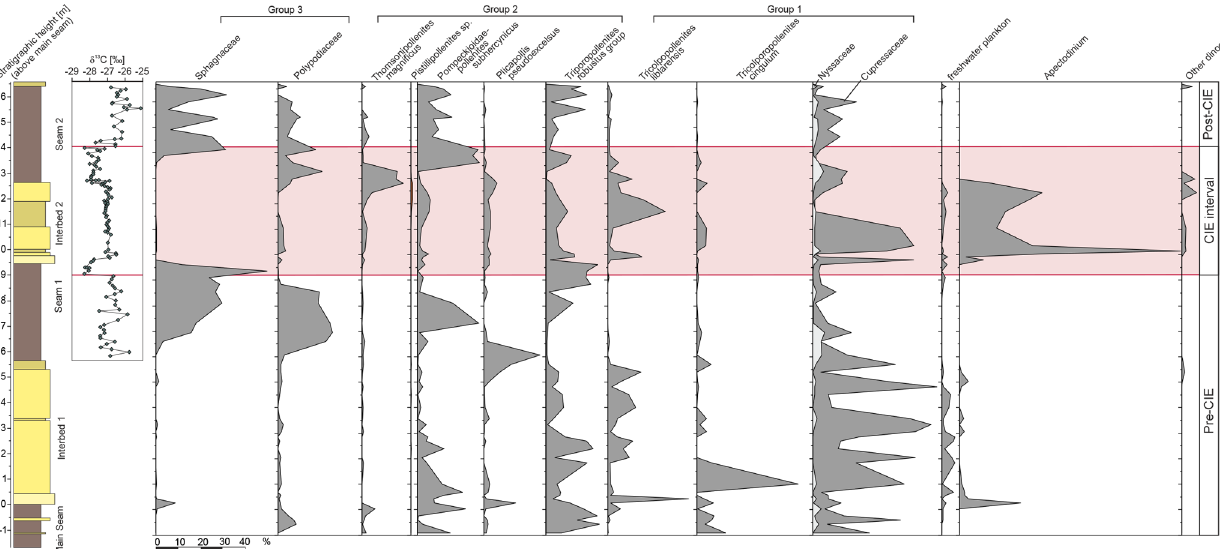
Figure 5. Simplified pollen diagram of the top of the Main Seam up to the top of Seam 2, showing frequency and palynological abundance changes between pre-, peak-, and post-CIE intervals. The carbon isotope data are shown for comparison. Due to the different thicknesses of the sections (see Fig. 2), it has been tied to the top and base of Seam 1 and the top and base of Seam 2. The red bar indicates the carbon isotope excursion. The palynological record is characterized by three palynological groups: (1) elements with frequency maxima in the clastic interbeds (representing the hinterland), (2) interbed–lignite seam transitional elements and back mangrove equivalents, and (3) elements dominating the lignite